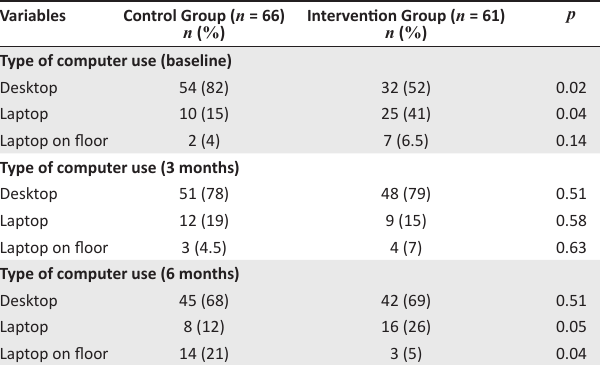
TABLE 2: Positions and type of computer usage at baseline, 3 months and over a period of 6 months ( n =